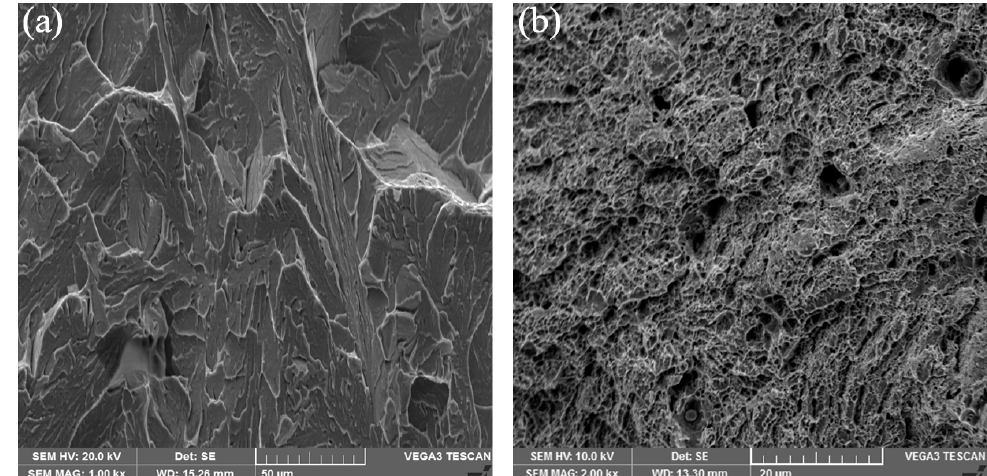
Figure 9. Typical fracture surface SEM images of the joints: ( a ) without PWHT and ( b ) with PWHT, at 730 °C for 2h.